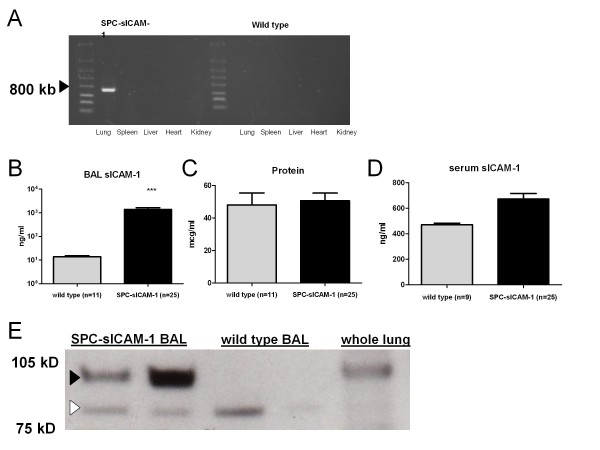
Characterization of SPC-sICAM-1 transgenic mice. Transgene-specific primers demonstrated lung-specific expression of the SPC-sICAM-1 transgene in the lungs, with no expression detected in wild-type mice (a). Protein expression in SPC-sICAM-1 in BALF was increased (~2 log fold) over wild type mice (b, *** P < 0.05 by t-test), but did not significantly affect total BALF protein or serum sICAM-1 expression (c, d). Western analysis of BALF demonstrates a larger protein (~100 kDA, black arrowhead) in SPC-sICAM-1 BALF not present in wild type BALF. The lighter bands (white arrowhead) represent endogenous processing of sICAM-1. Whole lung mince from a wild type mouse is included for comparison. Two representative mice are shown for SPC-sICAM-1 (F1 generation) and wild type mice (e).